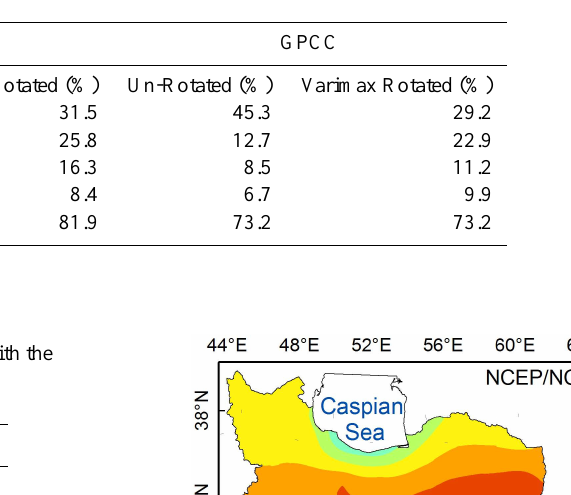
Table 3. Percentages of the explained variances of un-rotated and Varimax rotated PCs of SPI on 24-month time scale for NCEP/NCAR and GPCC.